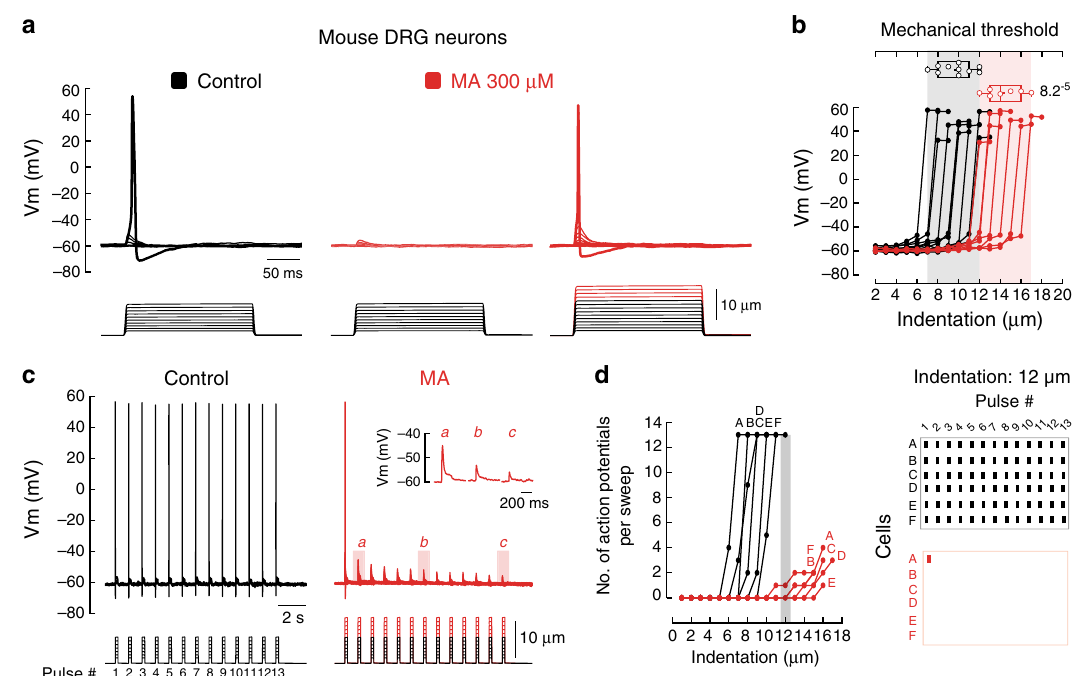
Fig. 4 MA decreases action potentials elicited by mechanical stimuli in mouse DRG neurons. a Representative current-clamp recordings of membrane potential changes elicited by mechanical stimulation in control and MA (300 µ M)-treated mouse DRG neurons (up to 10 and 15 µ m indentation, respectively). b Membrane potential peak vs. mechanical indentation of independent control (black; n = 10) and MA-treated (red; n = 7) mouse DRG neurons. Top panel shows the displacement threshold required to elicit an action potential in these neurons. Boxplots show mean (square), median (bisecting line), bounds of box (75 th to 25 th percentiles), outlier range with 1.5 coef fi cient (whiskers), and minimum and maximum data points. Two-tailed unpaired t -test. p -value is denoted on the right. c Representative current-clamp recordings of membrane potential changes elicited by a 1 Hz mechanical stimulus train of control (black) and MA-treated (red) mouse DRG neurons. Inset illustrates the progressive decrease in membrane potential as the pulse number progresses. d Left: number of action potentials elicited per sweep vs. mechanical indentation of control (black; n = 6) and MA-treated (red; n = 6) mouse DRG neurons. Right: raster plots displaying the action potentials elicited by 12 µ m of indentation. Bars indicate stimuli that elicited action potentials. Columns and rows represent cells and sweeps,